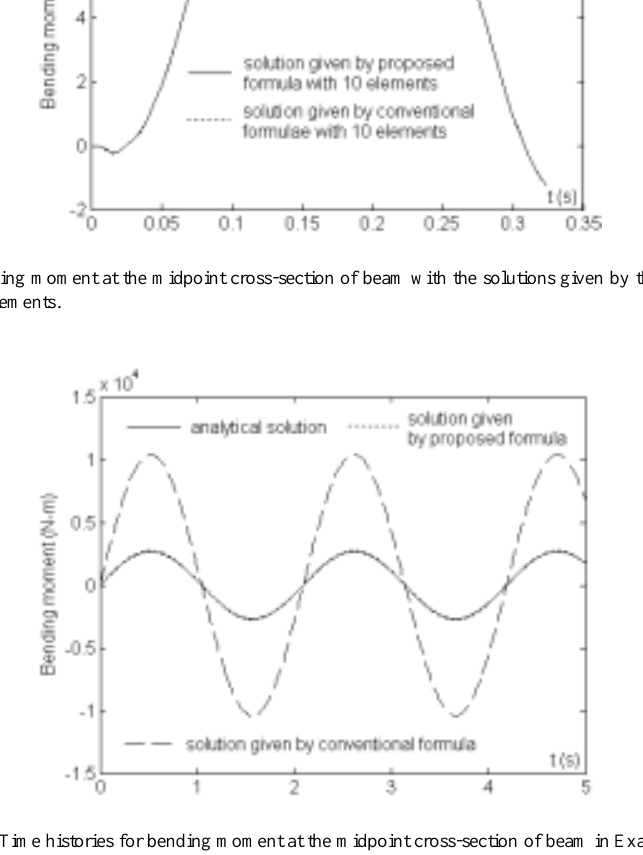
Fig. 13. Time histories for bending moment at the midpoint cross-section of beam in Example